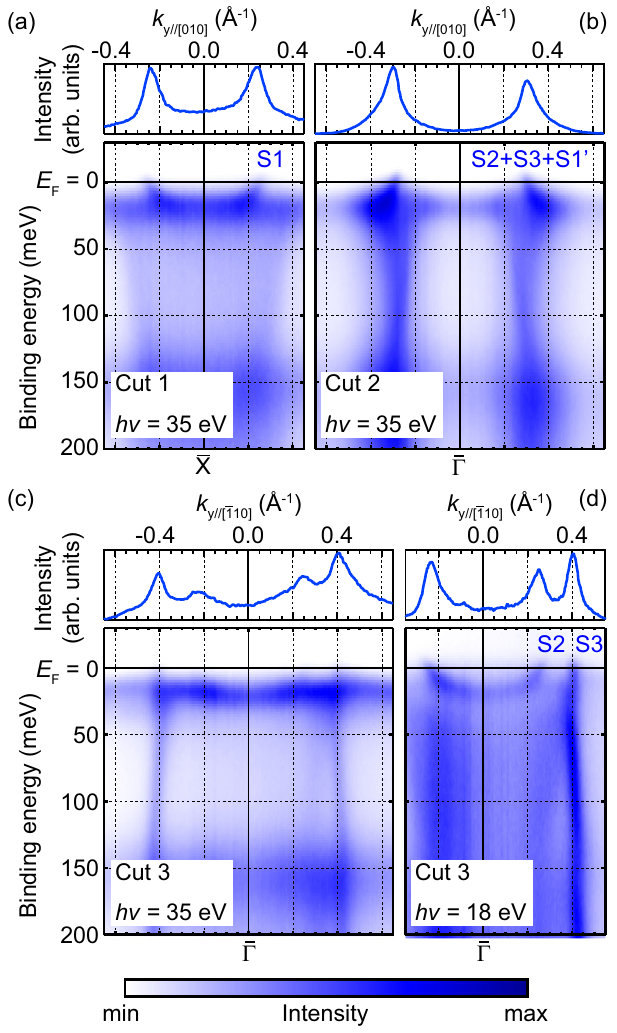
Fig. 3 | Band dispersions of SmB 6 (001)- p (2×2). ARPES intensity plots with the same condition asinFig.2 togetherwith the momentum distribution curvescut at (cid:1) X- (cid:1) M (Cut 1), ( b ) (cid:1) Γ - (cid:1) X (Cut 2), and ( c , d ) (cid:1) Γ - (cid:1) M (Cut 3) E F , measured along the ( a )